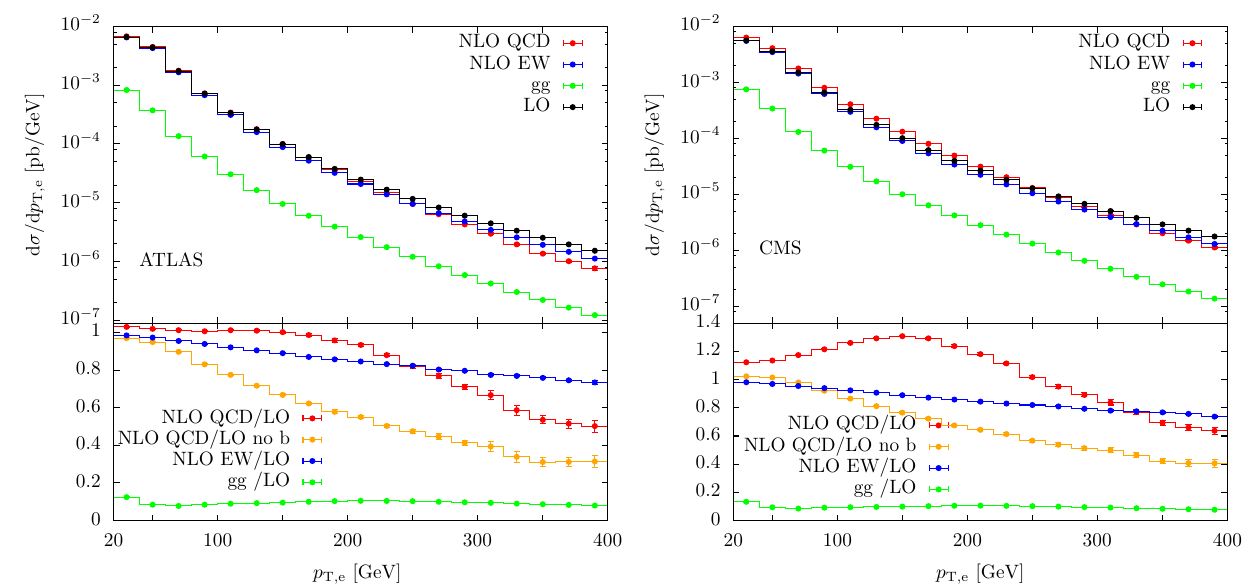
Fig. 2 Differential distributions in the transverse momentum of the lines, respectively). The orange lines correspond to the ratio of the NLO √ s = 13TeV for QCD corrections and the LO predictions if the processes with initial- positron ( p T , e ) for the process pp → e + ν e μ − ¯ ν μ at state b quarks are not included (see text for details). For all curves the the ATLAS and CMS event selections of Eqs. (4.4) and (4.5), respec- central value of the factorization and renormalization scales is used and tively. The LO results (black lines) are compared to the ones at NLO theerrorbarscorrespondtothestatisticalintegrationuncertainties.Note QCD (red lines) and NLO EW (blue lines). The gg contribution is that the same PDF set is employed for both the LO and NLO predictions also shown (green lines). Lower panels: ratio of the NLO QCD, NLO EW and gg contributions with respect to the LO (red, blue and green